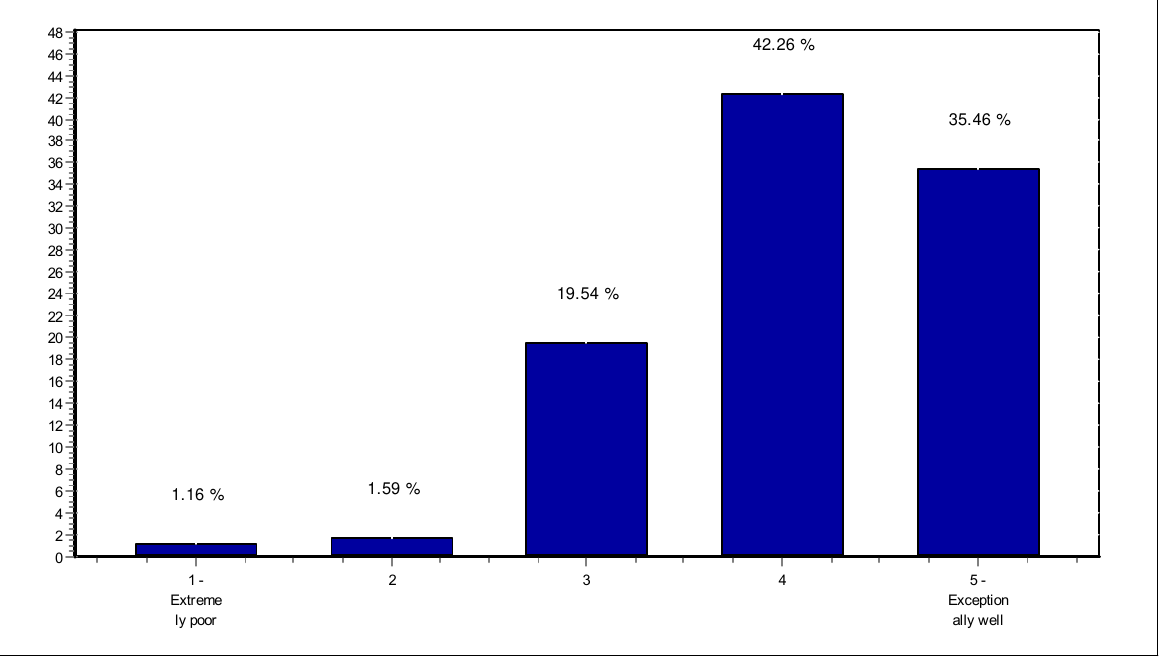
Fig. 6. Range of services on offer